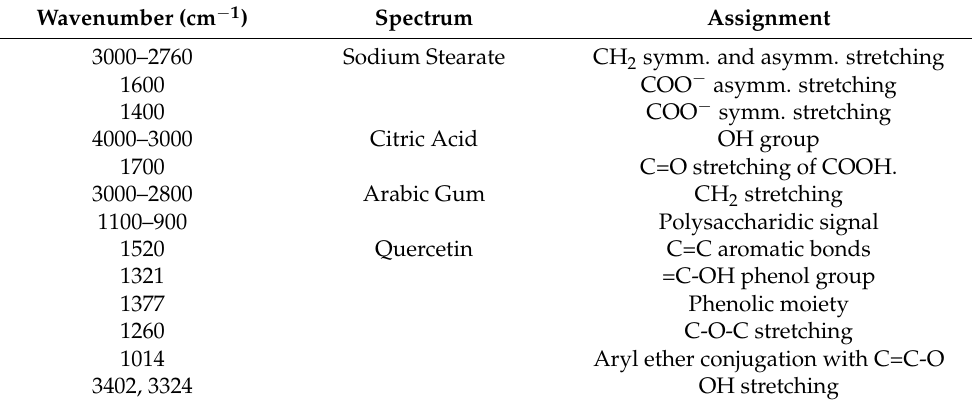
Table 3. Main wavenumbers observed and relative assignment.